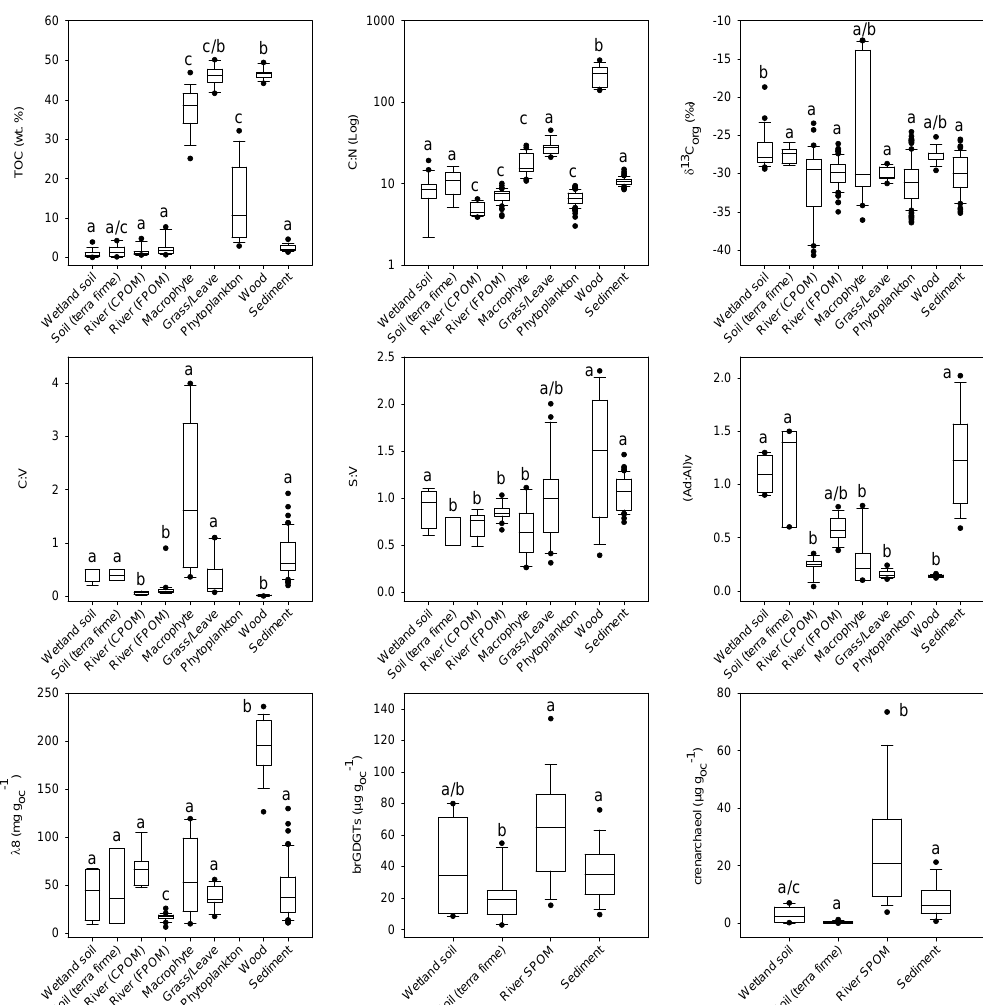
Figure 5. Box plots of average values of multiple biomarkers and bulk parameters in sediment samples and in potential sources on SOM. Data is based on previous studies (Hedges et al., 1986; Aufdenkampe et al., 2007; Zell et al., 2013b) and the present work (Table 3). Letters over the boxes indicate significant differences ( p <0.05) between the means. Table 5. Average values of biomarkers and bulk parameters in the possible sources of SOM and in sediment samples. The data were obtained in the present work and from the literature (Hedges et al., 1986; Hedges and Mann, 1979; Aufdenkampe et al., 2007). TOC C : N δ 13 C org C : V S : V (Ad : Al) v λ 8 brGDGTs crenarchaeol (wt.%) (‰ VPDB) (mgg − 1 Wetland soil 0.9